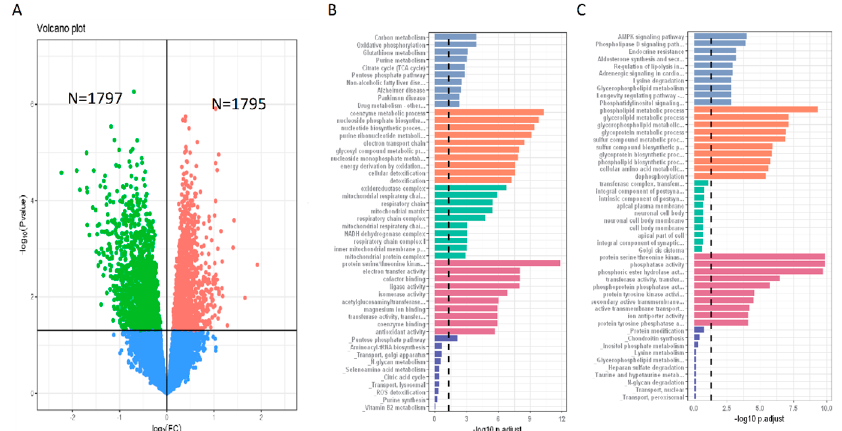
Figure 3. Metabolic profiles of N + P ‐ . ( A ): Volcano plot of differential reactions between the N + P ‐ and N ‐ P + . Up ‐ and down ‐ regulated reactions in N + P ‐ are colored red and green, respectively. ( B ): Differential met ‐ abolic pathways between the N + P ‐ and N ‐ P + . ( C ): Overall metabolic changes in N + P ‐ . The overall metabolic map of Recon was downloaded from the Virtual Metabolic Human Database (https://vmh.uni.lu/). Three general metabolic pathways, including carbohydrate metabolism, amino acid metabolism, and fatty acid metabolism, are colored green, orange, and purple, respectively. The significantly up ‐ and down ‐ regu ‐ lated reactions in N + P ‐ are colored bold red and bold blue, respectively.